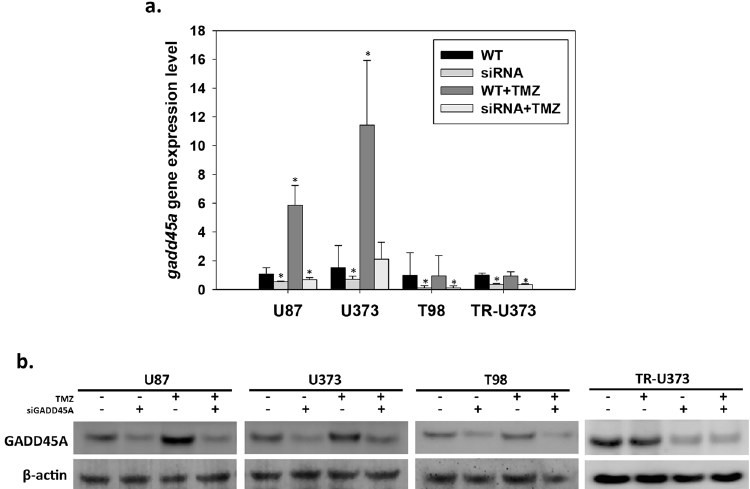
Figure 4. Knockdown GADD45A by specific siRNA in U87, U373, TR-U373 and T98 cells. The cells were pretreated with or without GADD45A siRNA before TMZ (25 μ g/ml) or DMSO only treatment. The cells were collected for RNA or protein extraction at day 4 after drug treatment. ( a ) Analysis of GADD45A mRNA expression in U87, U373, TR-U373 and T98 cell lines by qPCR. n = 3, * p < 0.05 ( b ) The expression of GADD45A protein in U87, U373, T98 and TR-U373 cell lines was analyzed by western blotting. Original blot was shown in Supplementary Fig.